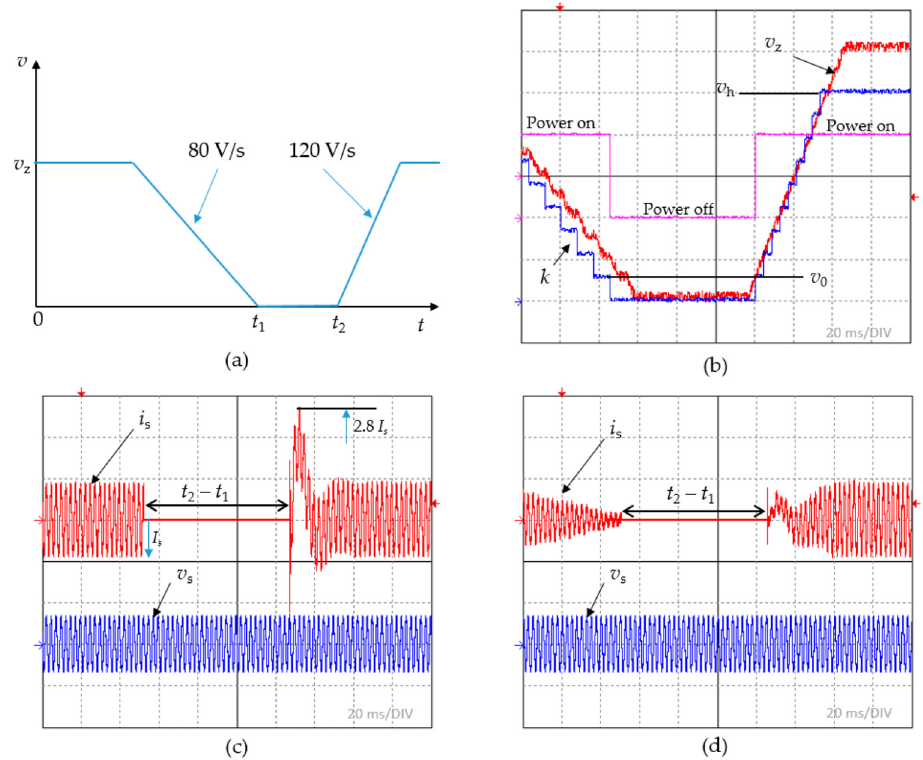
Figure 5. Dynamic response of the system to a voltage change on power bus 4: ( a ) assumed voltage profile on bus 4; ( b ) waveforms of the recorded voltage of bus 4 v z , correction factor k, and supply voltage identifier (pink color); waveforms of current i s and voltage vs. of bus 2 recorded in the classical system ( c ) and in the proposed system ( d